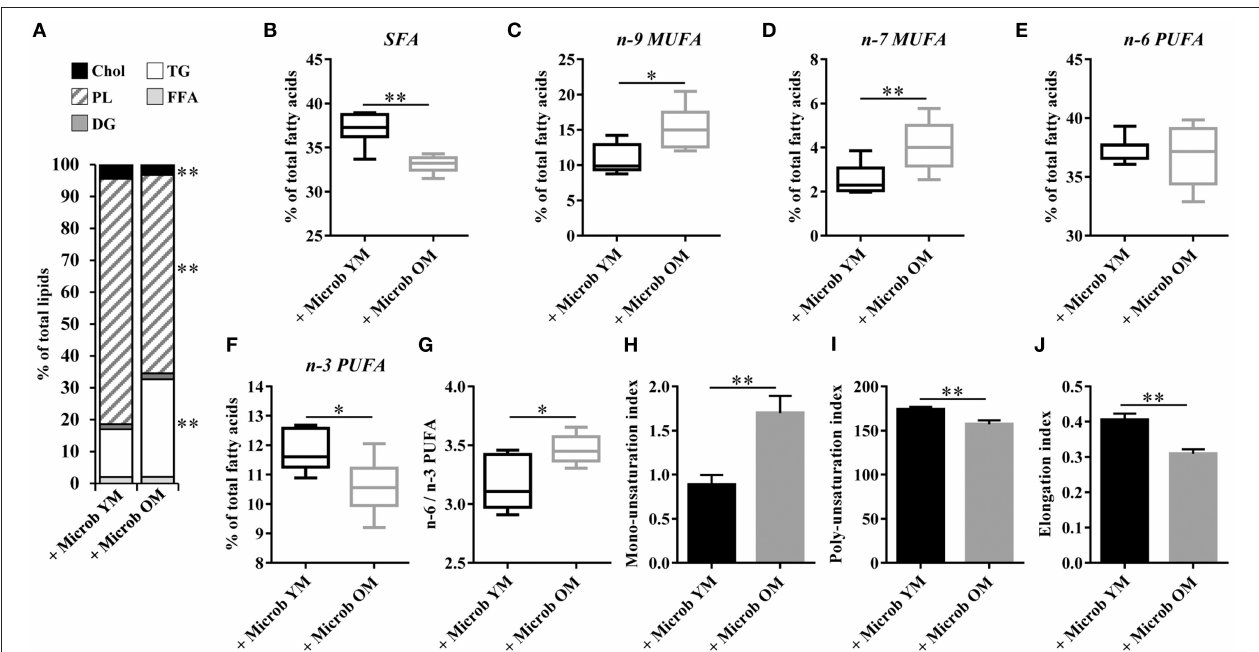
FIGURE 6 | Relative abundance of lipid classes and ester-linked fatty acids in the liver of mice inoculated with different age-related microbiota. Lipids were extracted from the liver of mice inoculated with fecal microbiota of young mice ( + Microb YM) or old mice ( + Microb OM). (A) Relative abundance of lipid classes. Results are expressed as the percentages of cholesterol (Chol), phospholipids (PL), diglycerides (DG), triglycerides (TG), and free fatty acids (FFA) relative to total lipids, defined as 100%. (B–J) The results presented were obtained from the analysis of the quantification data of fatty acid methyl esters (FAME) derivatives by GC-FID. Results are expressed as the percentages of total (B) saturated fatty acids (SFA), (C) omega-9 (n-9) monounsaturated fatty acids (MUFA), (D) omega-7 (n-7) MUFA, (E) omega-6 (n-6) polyunsaturated fatty acids (PUFA), and (F) omega-3 (n-3) PUFA relative to total fatty acids, defined as 100%. (G) Ratio of n-6/n-3 PUFA. (H) Mono-unsaturation index corresponding to the sum of the ratios “products” (C16:1n-7 and C16:1n-9)/“precursor” (C16) and “products” (C18:1n-7 and C18:1n-9)/“precursor” (C18). (I) Poly-unsaturation index corresponding to the sum of the amounts of each fatty acid that had more than on carbon-carbon double bond multiplied by its unsaturated bond number. (J) Elongation index corresponding to the ratio of fatty acids with 20-carbons and more/fatty acids with 16- and 18-carbons. All data are presented as mean ± SEM. n = 7 for the group of mice inoculated with the microbiota of young mice and n = 8 for the group of mice inoculated with the microbiota of old mice. Comparisons were done between the two groups of mice ( + Microb YM and + Microb OM). * p < 0.05 and ** p <